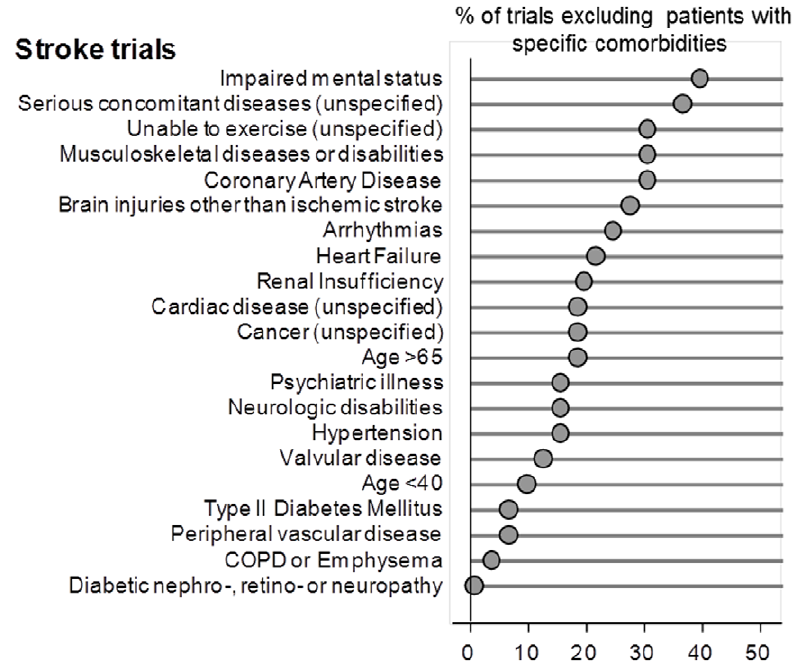
Figure 4. Proportion of stroke trials where patients with specific comorbidities were excluded.